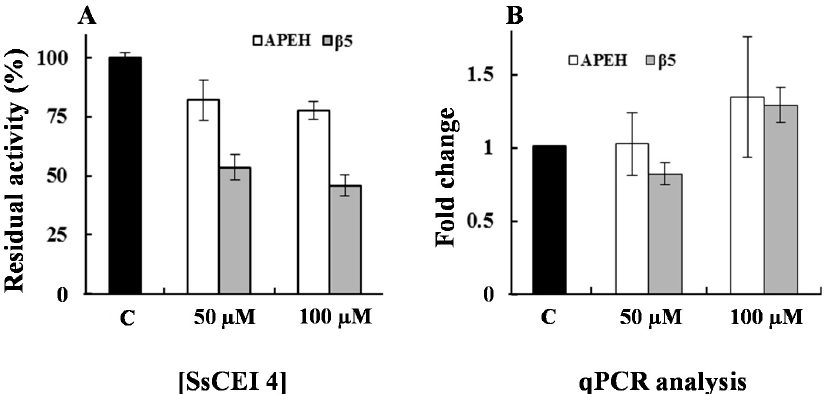
Figure 4. Anti-proliferative activity of SsCEI 4 correlates with the downregulation of APEH and proteasome in U2OS cells. ( A ) APEH (white bars) and CT-like proteasome (gray bars) activities were measured in pre-confluent U2OS cells incubated with 50 and 100 µM SsCEI 4 for 72 h. Untreated cells (C) were used as controls. Measurements of APEH or proteasomal CT-like activities were performed on cytoplasmic extracts; ( B ) The mRNA levels of APEH and β 5 proteasome subunit were evaluated by qPCR and expressed as fold change in comparison to untreated cells (C). Results are presented as the mean values ± SD of triplicate analyses from at least three different experiments.